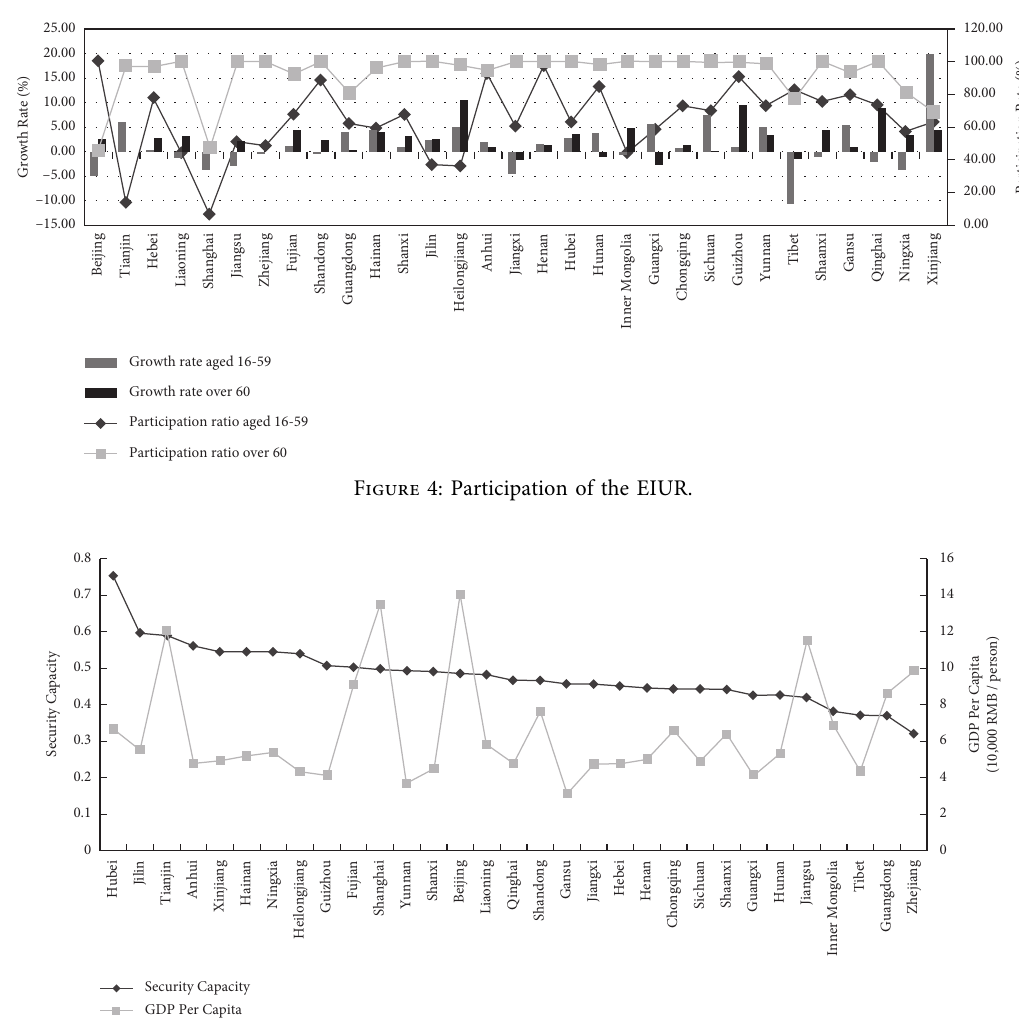
Figure 5: Security ability and GDP per